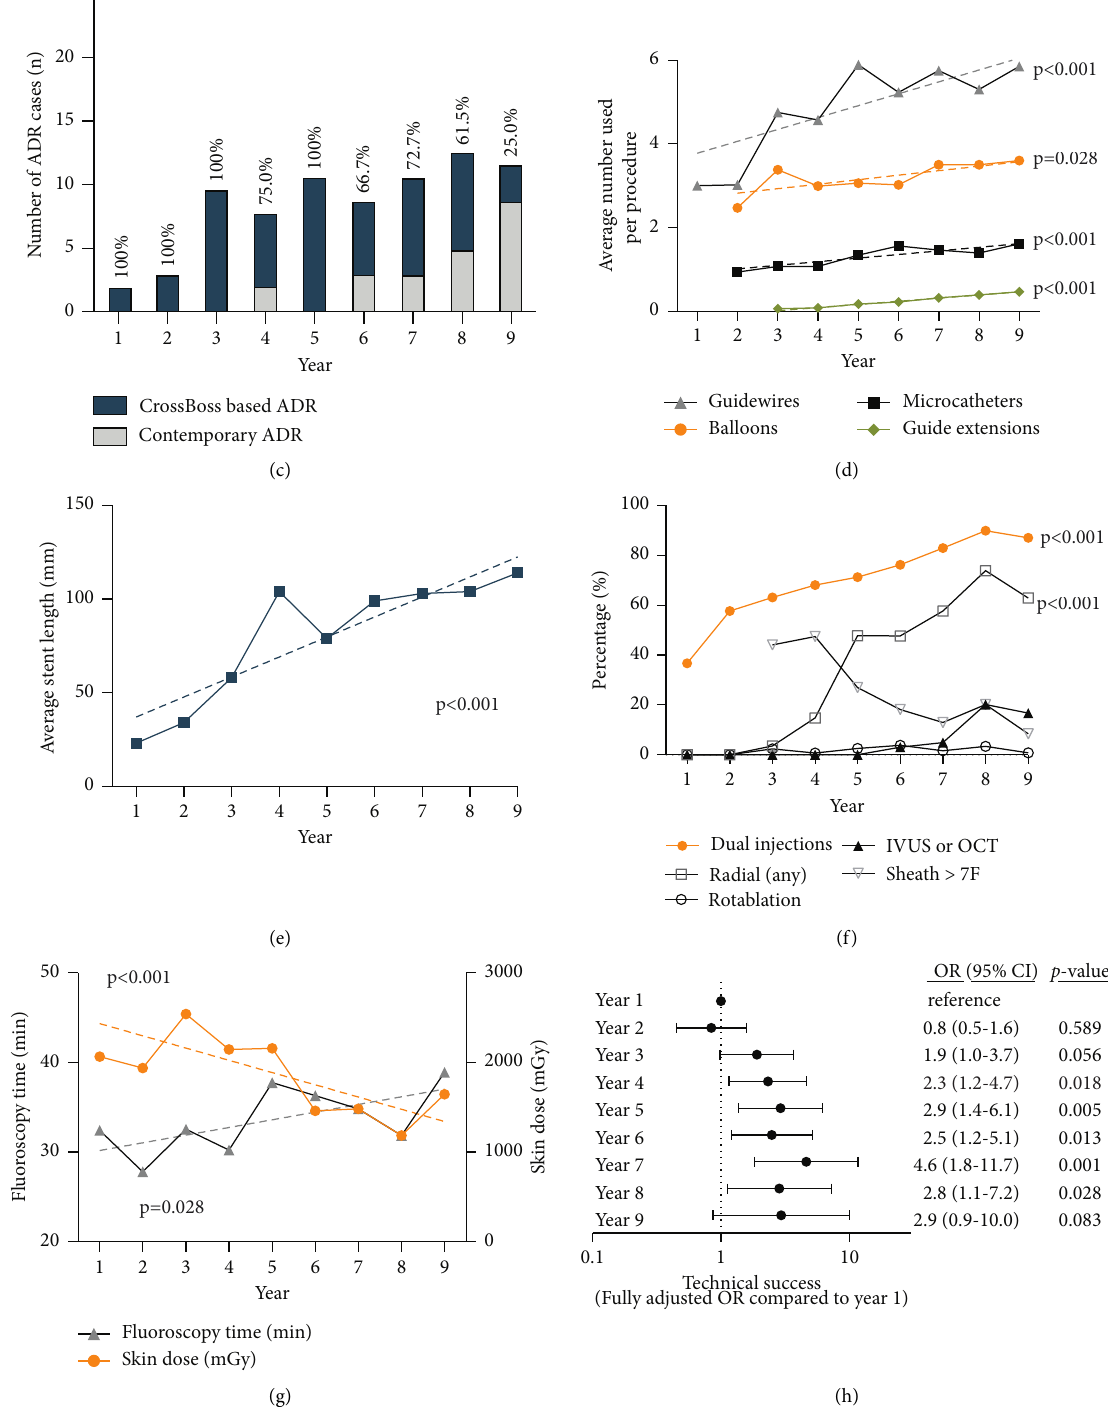
Figure 1: Temporal trends in the success rates and approaches of CTO PCI. (a) Significant improvement in technical success up to 85.6% and procedural success up to 84.1% in year 9 ( p value for trend both < 0.001). (b) Significant increase in the lesion complexity (increase in J-CTO score) ( p value for trend < 0.001), with an increase in retrograde and dissection/reentry techniques. (c) There was evolution from the use of the CrossBoss catheter to contemporary ADR techniques using dual or triple lumen microcatheters. (d) Temporal increase in the number of guidewires, microcatheters, and guide extensions (all p value for trend < 0.001) and balloons ( p � 0 . 028). (e) Increase in the average stent length ( p value for trend < 0.001).(f)More comprehensiveapproacheswithan increasein theuse ofdual injectionsand intracoronaryimaging but contemporary with an increase in at least one radial access and a decrease in sheaths larger than 7F (all p for trend < 0.001). (g) Temporal increase in fluoroscopy time ( p � 0 . 028) but decrease in the skin dose ( p < 0 . 001). (h) Regression model adjusted for age, LV EF, vessel, J-CTO score, the use of microcatheters, dual injections, and intracoronary imaging showing a significant increase in technical success starting from year 3 and year 4, compared to year 1 as reference. ADR, antegrade dissection/reentry; AWE, antegrade wire escalation; IVUS, intravascular ultrasound; J-CTO, Multicentre CTO Registry of Japan score; LV EF, left ventricular ejection fraction; OCT, optical coherence tomography; OR, odds ratio; RDR, retrograde dissection/reentry; RWE, retrograde wire